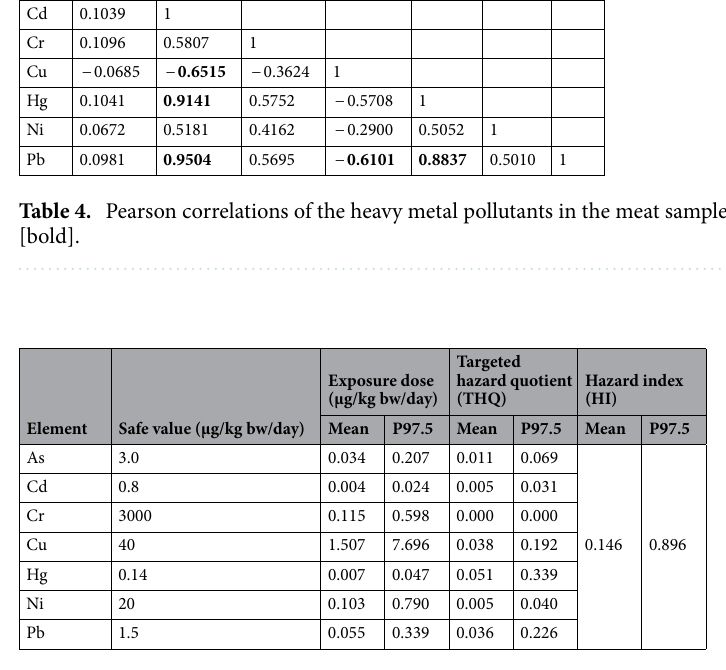
Element Safe value (μg/kg bw/day)